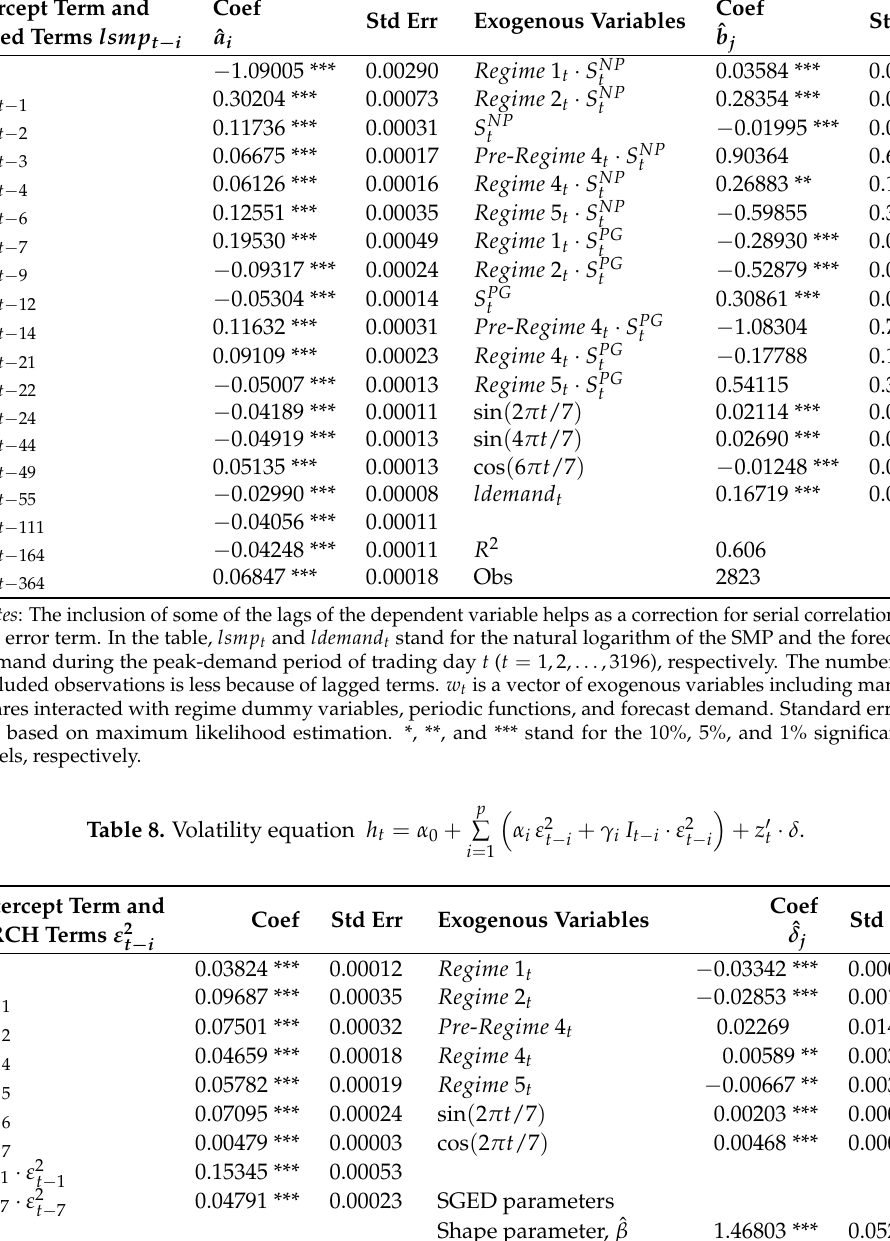
Table 7. Mean equation lsmp t = a 0 +